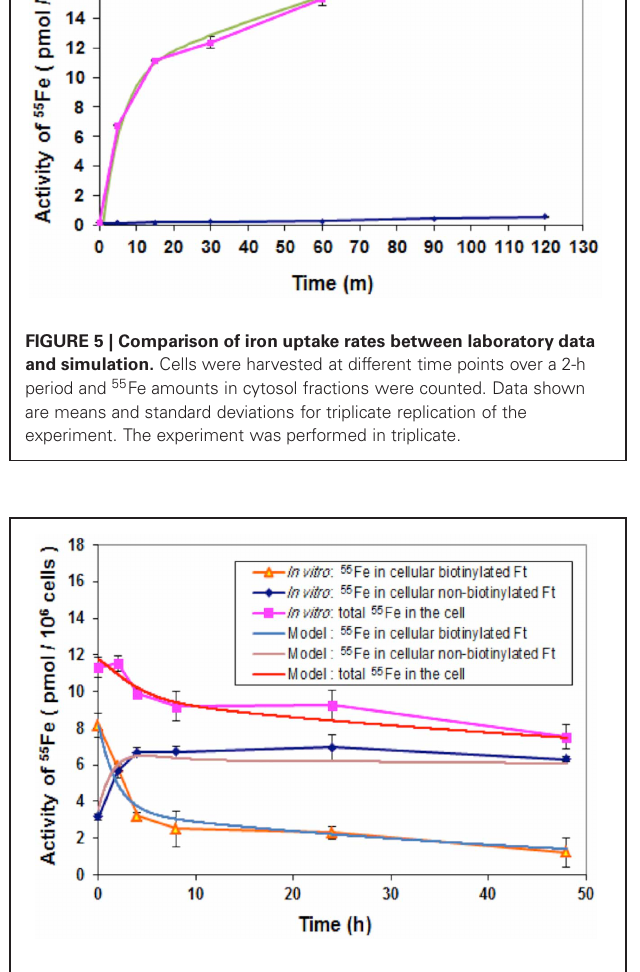
FIGURE 6 | Comparison of iron storage rates between laboratory data and simulation. Cells were treated with biotinylated HFt loaded with 55 Fe for various time points and the 55 Fe amounts in biotinylated and non-biotinylated fractions were counted. Data shown are means and standard deviations for triplicate replication of the experiment. The experiment was performed in